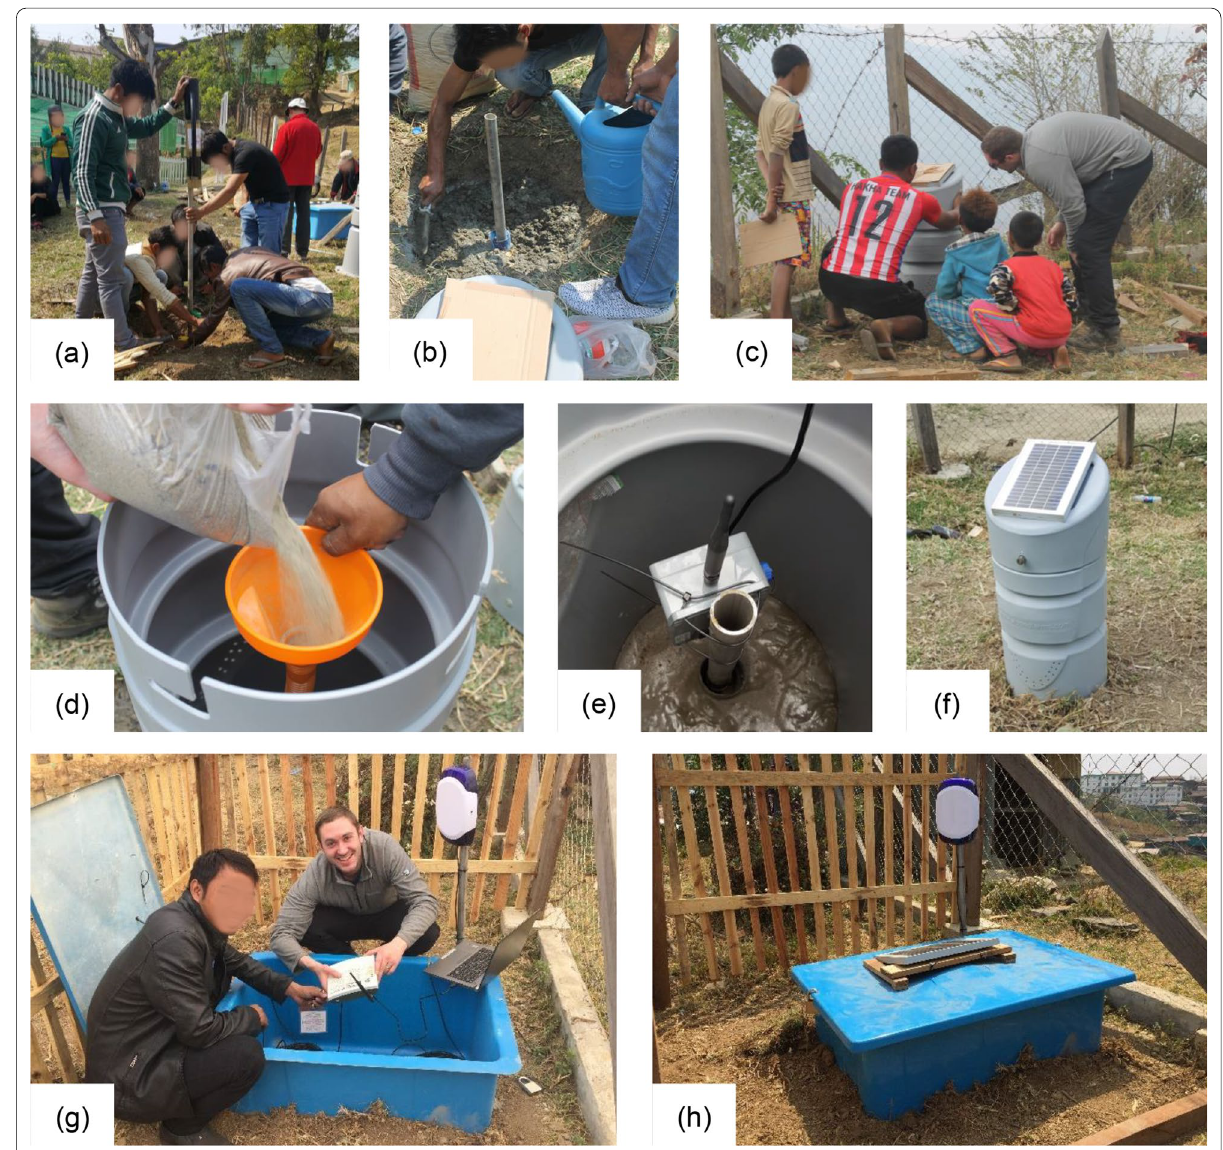
Fig. 7 Key stages of works by the authors, LRV and CCERR to install CSS at Sites 1 and 2: a driving the steel waveguide, b concreting the base for the cover, c placing the cover with help from interested children, d placing ‘noisy’ sand inside the steel waveguide, e the CSS sensor attached to the waveguide, f a completed sensor installation with integrated solar panel to charge the sensor battery, g set up of the base station and flashing light/siren alert system, h completed base station with solar panel to charge the